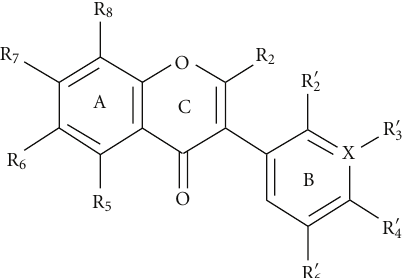
Figure 1: The isoflavones: generic 7-hydroxy-benzopyran-4-one ligands for PPAR γ . Isoflavones have a B-ring aryl substituent in the 3-position and a Δ 2 − 3 double bond. Common isoflavones are daidzein (R 5 = R 6 = R 8 = H, R 7 = R (cid:2) 4 = OH, R (cid:2) 2 = R (cid:2) 3 = R (cid:2) 5 = H (cid:2) ), genistein (R 6 = R 8 = H; R 5 = R 7 = R (cid:2) 4 = OH; R (cid:2) 2 = R (cid:2) 3 = R (cid:2) 5 = H (cid:2) ), formononetin (R 5 = R 6 = R 8 = H; R 7 = OH; R (cid:2) 2 = R (cid:2) 3 = R (cid:2) 5 = H; R (cid:2) 4 = OCH 3 ), and biochanin A (R 6 = R 8 = H; R 5 = R 7 = OH; R (cid:2) 2 = R (cid:2) 3 = R (cid:2) 5 = H; R (cid:2) = OCH 3 ). The chemical library search also showed that the 4 atom at position-3 in the B-ring can be either carbon or